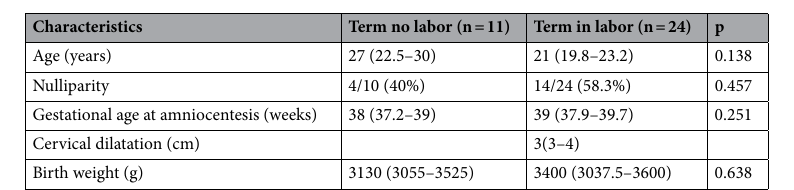
Table 1. Demographic characteristics of the amniotic fluid study cohort. Continuous variables were compared with the use of Welch’s t-test and are summarized as the median (interquartile range). Categorical variables are shown as a number (%) and were compared with the use of Fisher’s exact